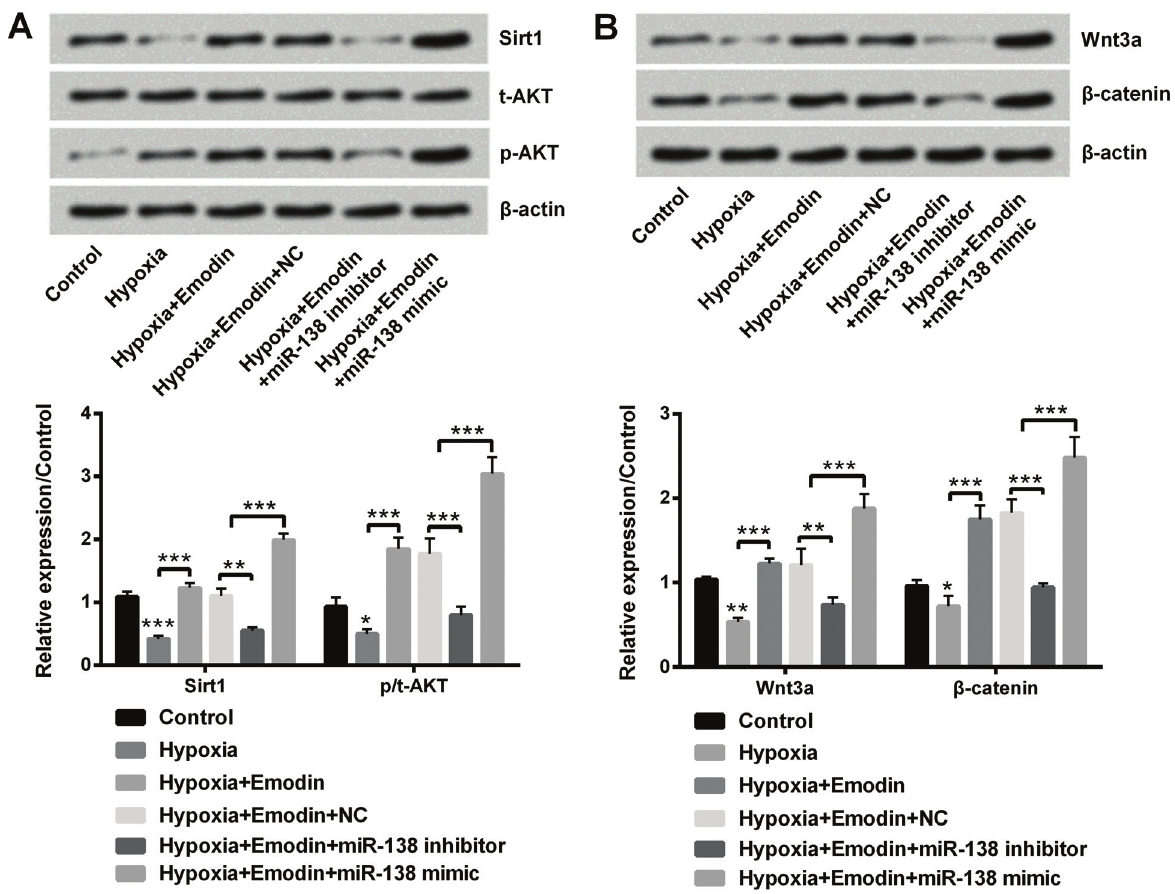
Figure 6. Sirt1/AKT and Wnt/ b -catenin signaling pathways were activated by emodin. Emodin promoted activations of ( A ) Sirt1/AKT pathway and ( B ) Wnt/ b -catenin pathway by up-regulating miR-138. The expression of protein was measured by western blot. Data are reported as means ± SD of triplicates. Each experiment was performed three times. NC: negative control. *P o 0.05, **P o 0.01, ***P o 0.001 compared to control or as indicated (one-way analysis of